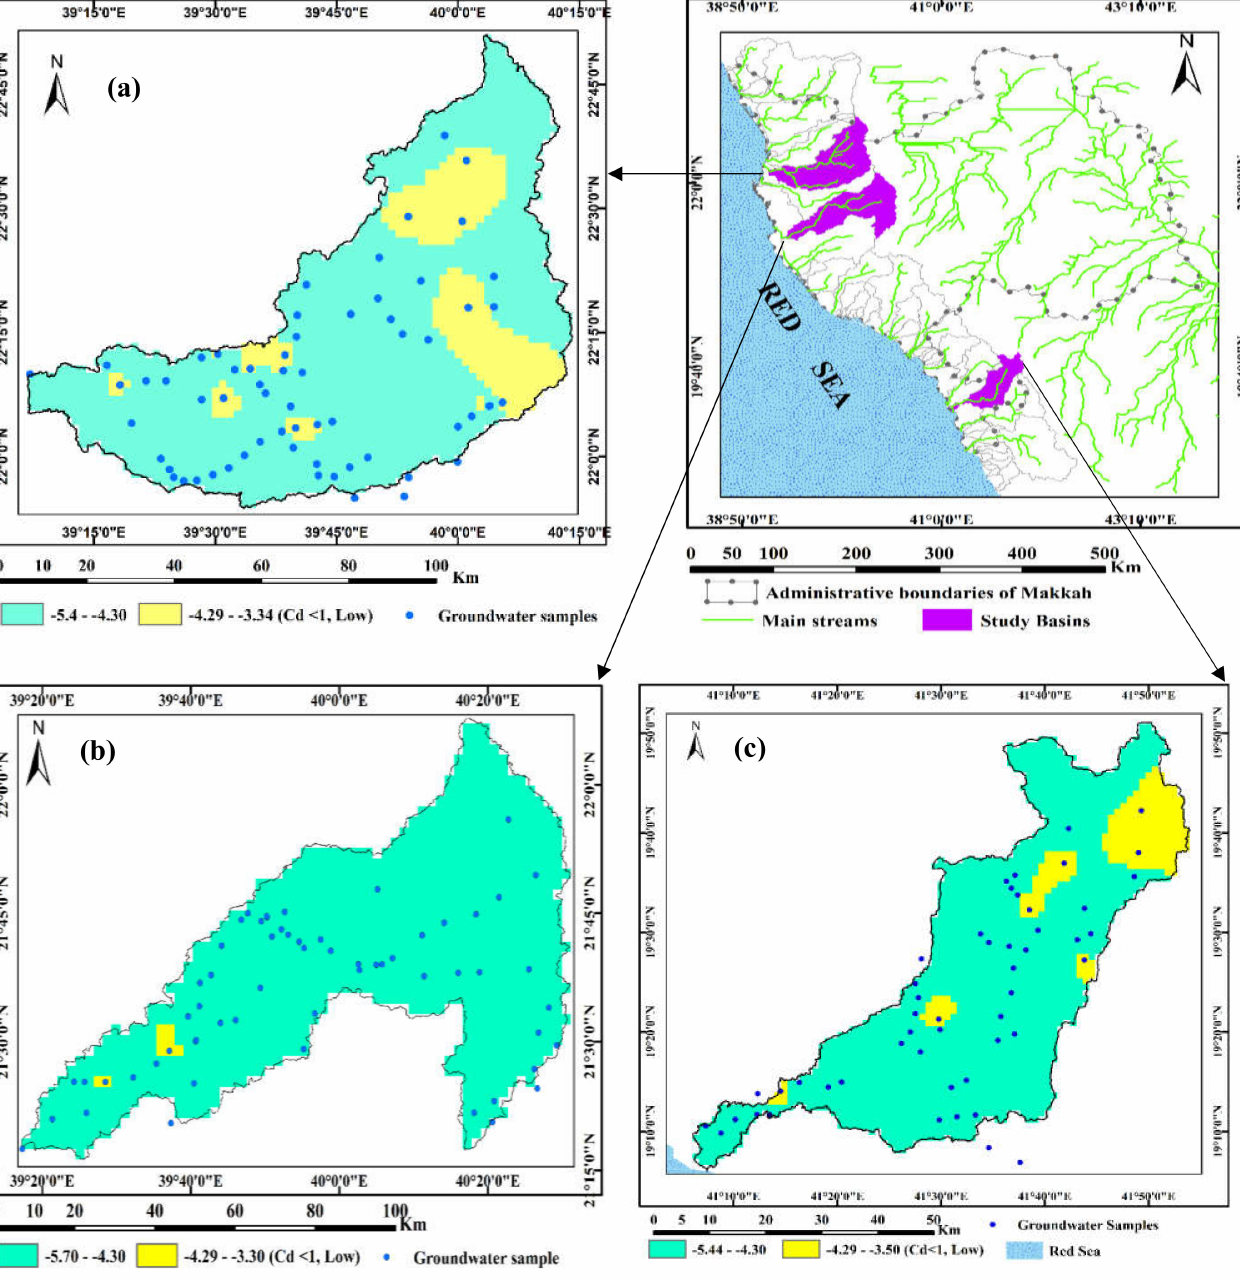
Figure 10. Spatial distribution map of C d for selected wadies: ( a ) Wadi Marawani, ( b ) Wadi Fatimah, and ( c ) Wadi Qanunah, Makkah Al-Mukarramah